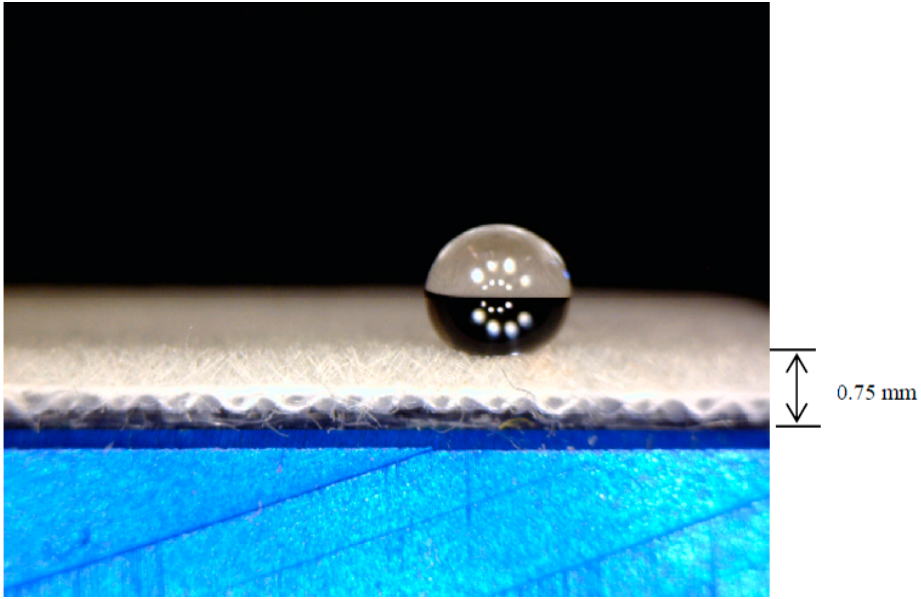
Figure 7. Photo showing contact angle of plasma-modified